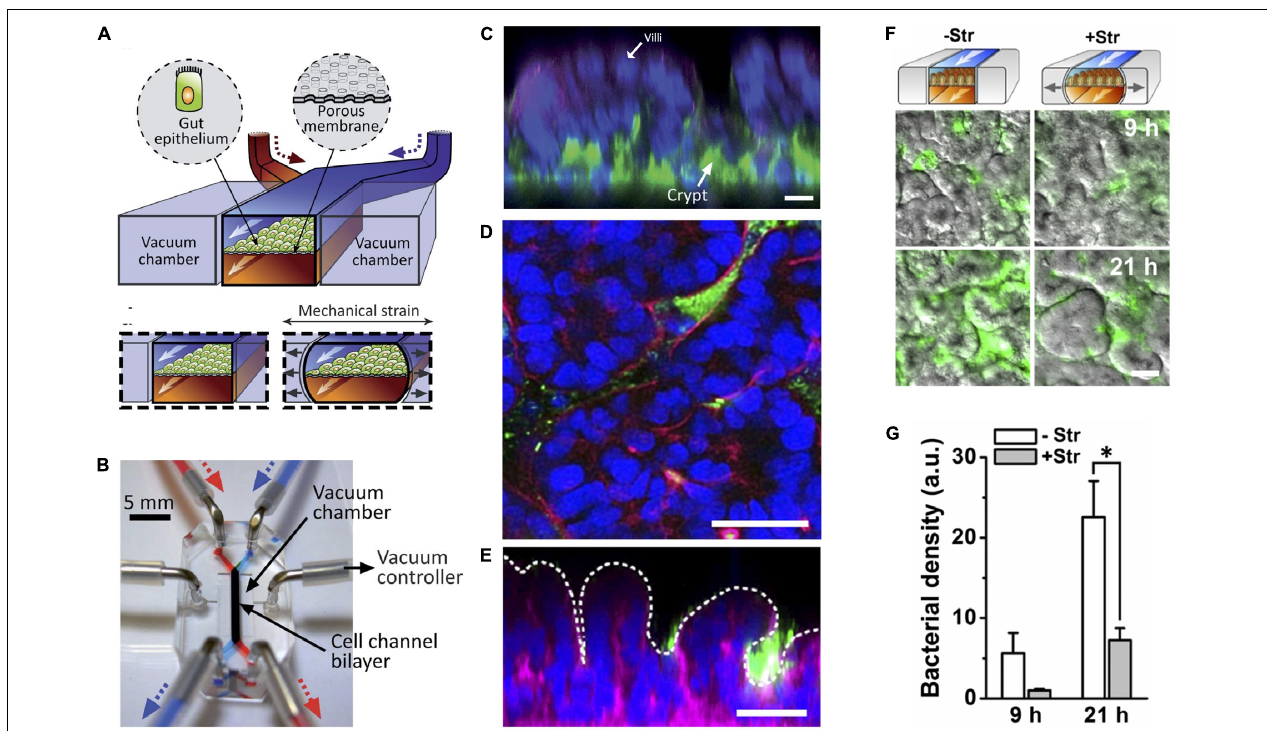
FIGURE 3 | State of the art in gut-on-a-chip platforms. (A) Illustration of the cross section of an organ chip with two chambers and flanking vacuum chambers, which are used to perform mechanical deformation. Gut epithelial cells are grown on top of a porous membrane. The upper (epithelial) chamber is perfused by the blue pump and the lower chamber is perfused by the red pump. Two lateral chambers allowed application of vacuum to the side chambers to produce cyclic mechanical strain in the direction of the arrows to mimic peristalsis (Reproduced from Huh et al., 2013 with permission from The Royal Society of Chemistry). (B) Photograph of the organ chip constructed from PDMS elastomer with the upper (epithelial) chamber infused by a syringe attached to a pump with a blue dye and the lower chamber being infused with a red dye. The direction of fluid flow is in the direction of the arrows. Cells are seeded in the labeled cell channel. Application of vacuum to produce cyclic mechanical deformation is performed through tubing attached to vacuum chambers flanking the main micro channel using a vacuum controller (Reproduced from Huh et al., 2013 with permission from The Royal Society of Chemistry). (C) Caco-2 cells grown under cyclic mechanical strain formed of three-dimensional “villus-like” structures and crypts. Immunofluorescence staining with DAPI nuclear staining (blue), f-actin (green), and mucin staining (magenta). (Reproduced from Huh et al., 2013 with permission from The Royal Society of Chemistry). (D) Horizontal and (E) vertical cross-sections of green fluorescent protein (GFP) expressing E. coli (green) co-cultured with Caco-2 cells on-a-chip (DAPI nuclear stain in blue; F-acin stain in magenta). Dotted line represents the villous surface of these intestinal cells. (F) Cessation of mechanical strain (deformation) leads to bacterial overgrowth as seen in Caco-2 cells grown with GFP expressing E. coli . (G) Quantification of bacterial overgrowth. + Str = cells and bacteria grown in the presence of mechanical strain. – Str = without mechanical strain. (Reproduced from Kim et al., 2016 with permission from The National Academy of Science). *Represents statistical significance as determined by p -value <